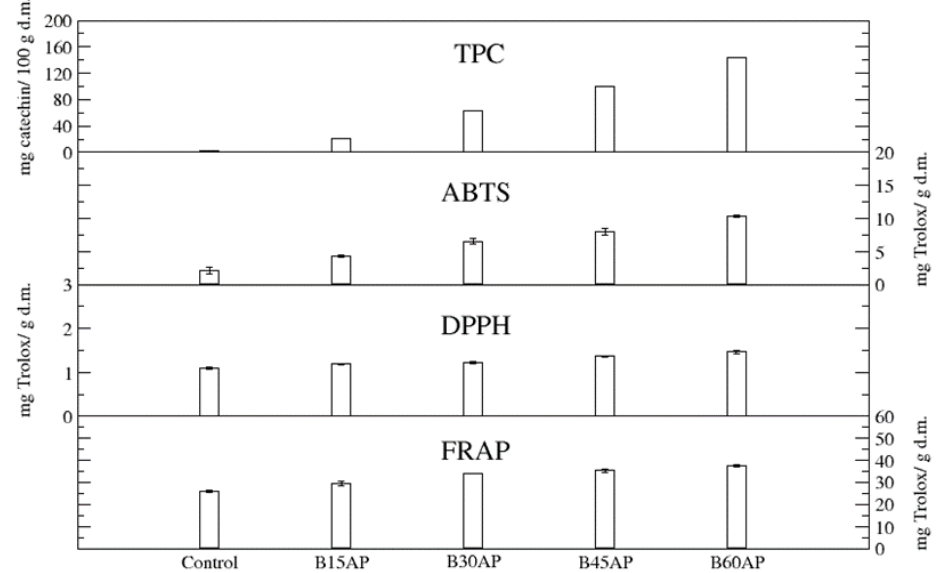
Figure 2. TPC and antioxidant potential of gluten-free cookies with apple pomace ( n = 2).